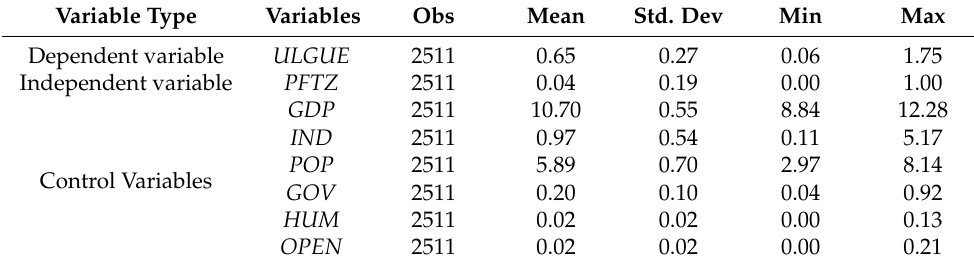
Table 2. Summary